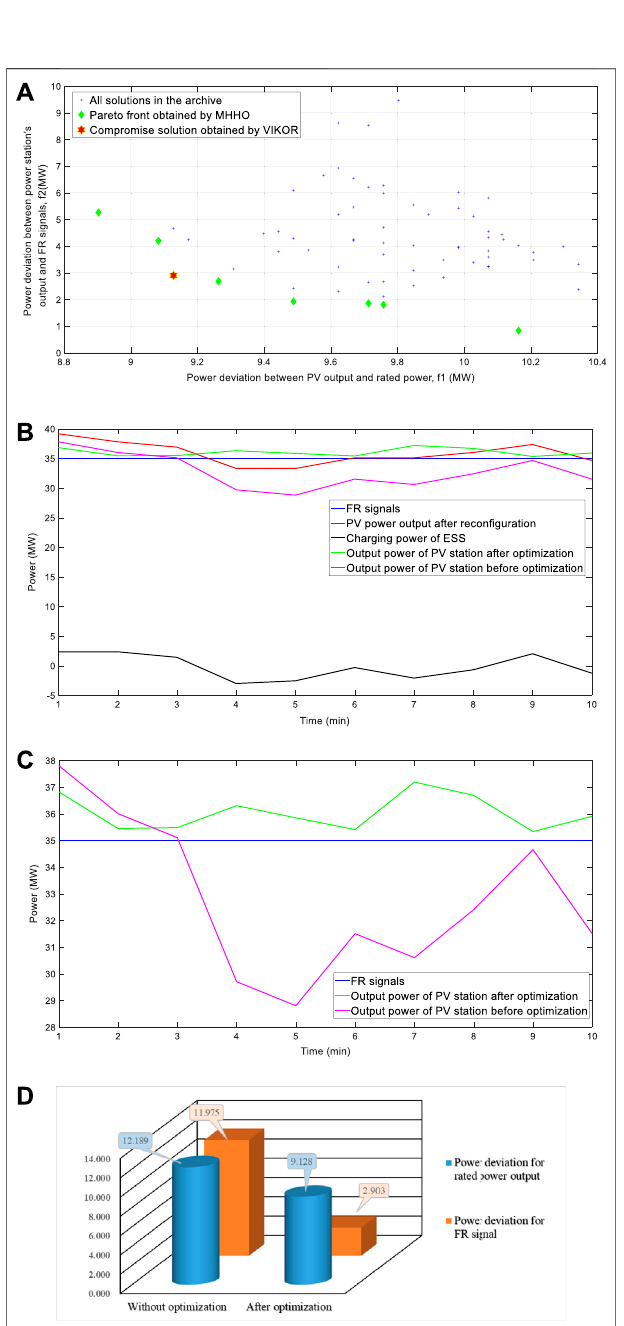
FIGURE 4 | The optimal solution and the comparison between the optimized results and original ones for constant FR signals test: (A) Pareto front obtained by MHHO and optimal compromise solution by VIKOR, (B) output results responding to FR signals, (C) power output curve of PV power station before and after optimization and (d) comparison of optimized power deviation with those of the original.